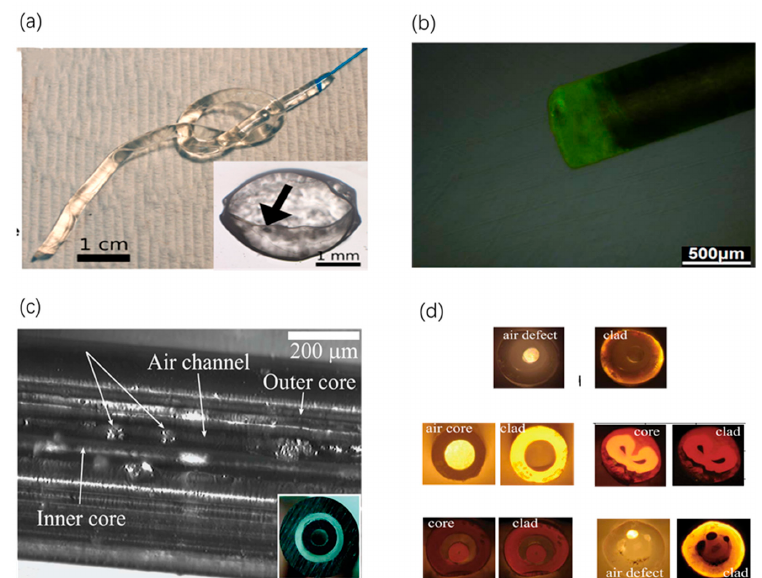
Figure 2. Natural polymer-based waveguides. ( a ) Highly flexible silk waveguide coupled with a glass fiber. Reprinted with permission from [25]. Copyright 2015, OSA. ( b ) Recombinant spider silk optical waveguide with obvious light spot at the terminal. Reprinted with permission from [27]. Copyright 2017, ACS. ( c ) Double-core biodegradable microstructured fiber with a structure of an inner core, air channel and outer core. Inset, preform cross section. The fiber preform [inset] was prepared by using commercially available cellulose butyrate (CB) tubes (refractive index 1.475) of two different